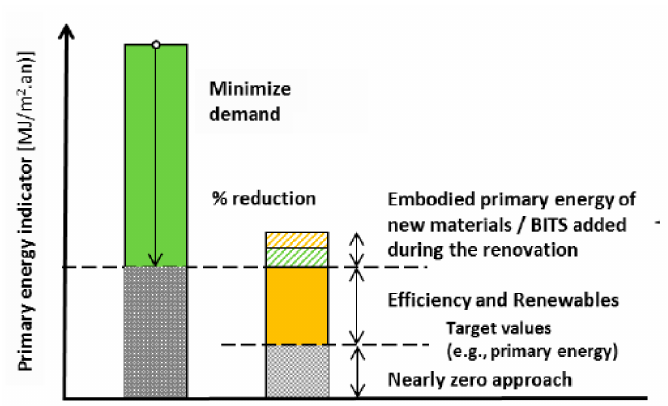
Figure 2. Effect of energy renovation measures in terms of embodied energy. Source: [26]. BITS: Building integrated technical